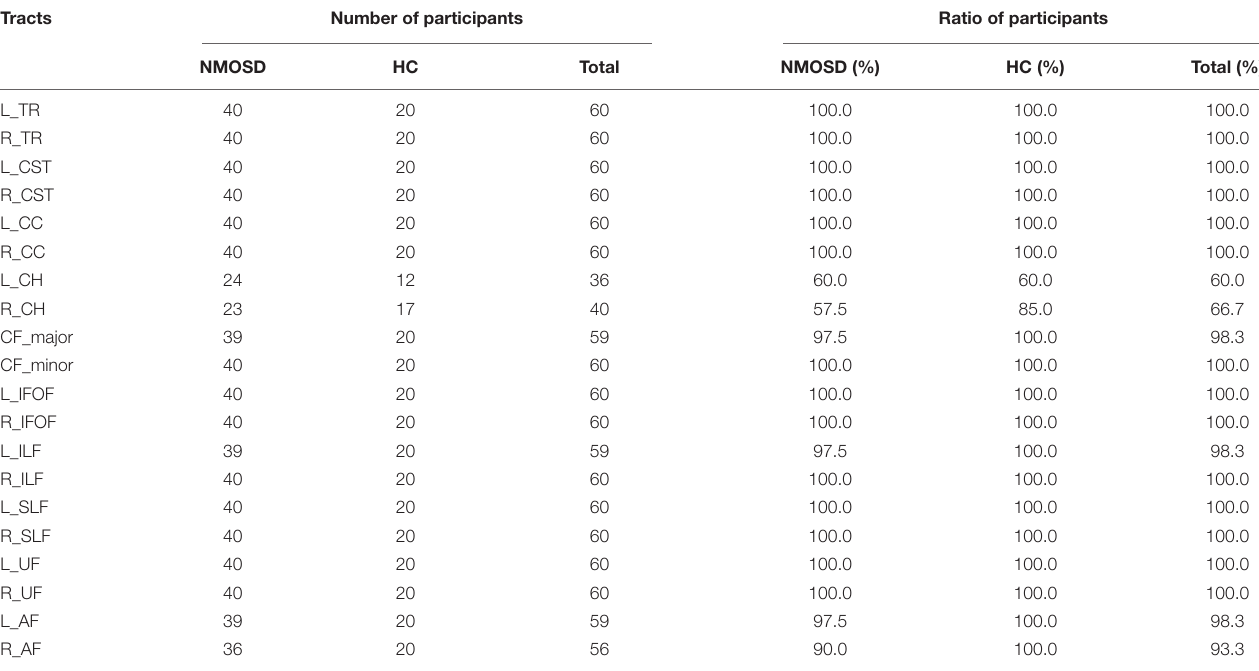
TABLE 1 | Identification number and ratio for 20 WM fiber tracts in NMOSD and HC. Tracts Number of